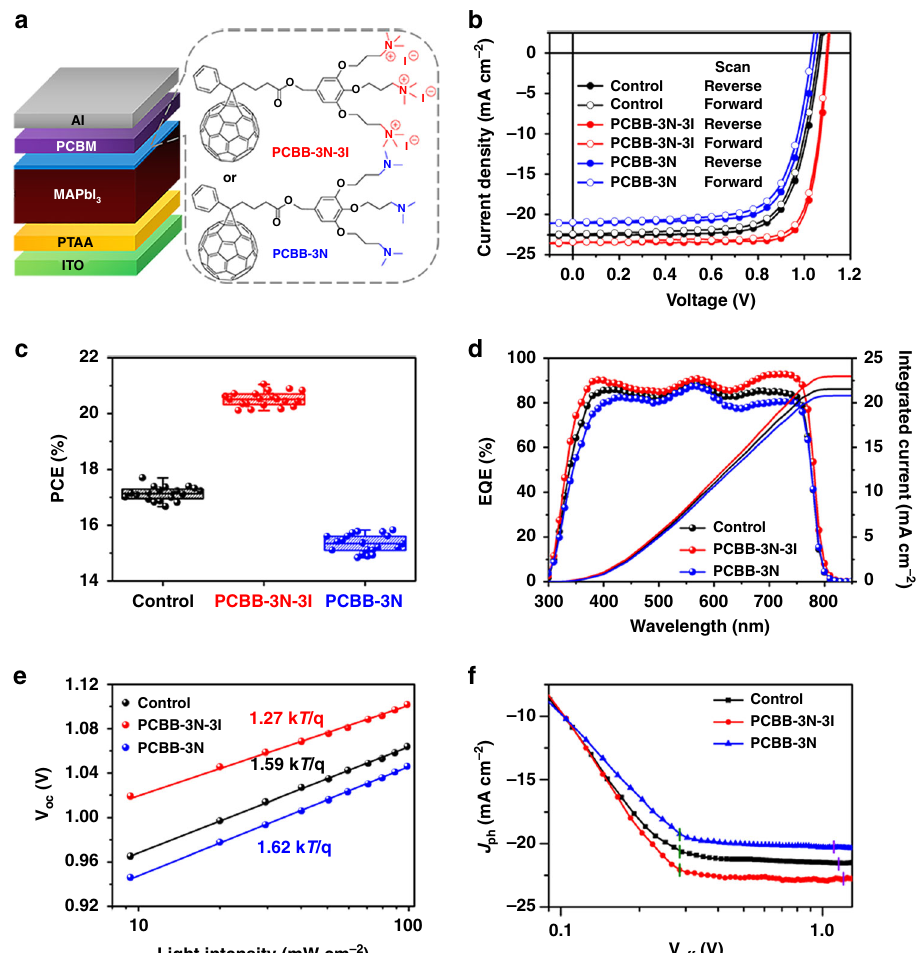
Fig. 1 Device performance of pero-SCs. a Schematic illustration of layer-stacking of pero-SCs with a structure of ITO/PTAA/MAPbI 3 /PCBM/Al with and without PCBB-3N-3I/PCBB-3N treatment on MAPbI 3 . b J – V curves of champion devices under AM 1.5 G illumination at a scan rate of 0.02 V s − 1 for both forward (0 to 1.2 V) and reverse (1.2 to 0 V) scanning. c Statistics of PCEs for control, PCBB-3N-3I, and PCBB-3N devices. The error bars are SD in PCE of 20 devices for each structure. d EQE spectra and integrated current of champion devices. e Light intensity-dependent V oc for pero-SCs. f J ph vs. V eff curves of the pero-SCs